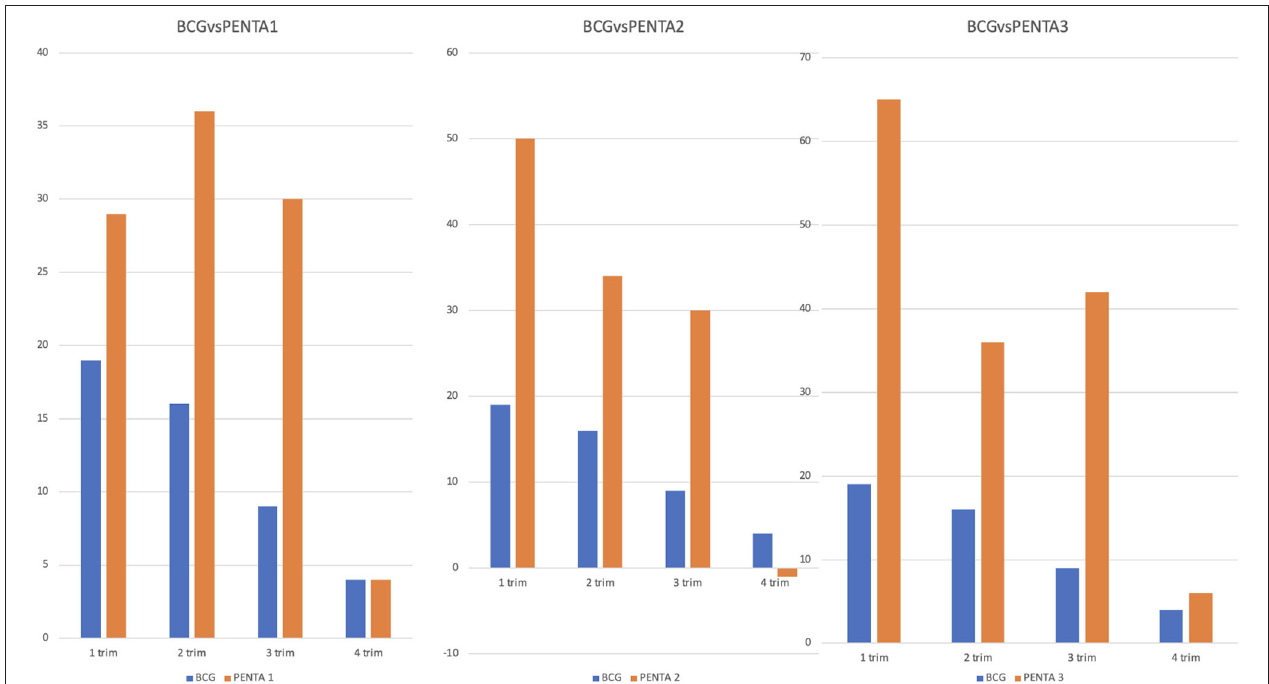
FIGURE 3 | Comparison between BCG and PENTA1, PENTA2, and PENTA3 in the different trimesters. The figure compares the difference between the 2 years of a vaccine performed at birth (BCG) with the difference between the 2 years of three vaccines administered at different time-points (PENTA1, PENTA2, and PENTA3). On the ordinates we reported the differences in absolute number between the vaccines performed in the first and in the second year for each trimester. Although the BCG vaccine shows a generally minor reduction than all the three PENTA, this reduction becomes statistically significant only for the PENTA3 in the first and in the third